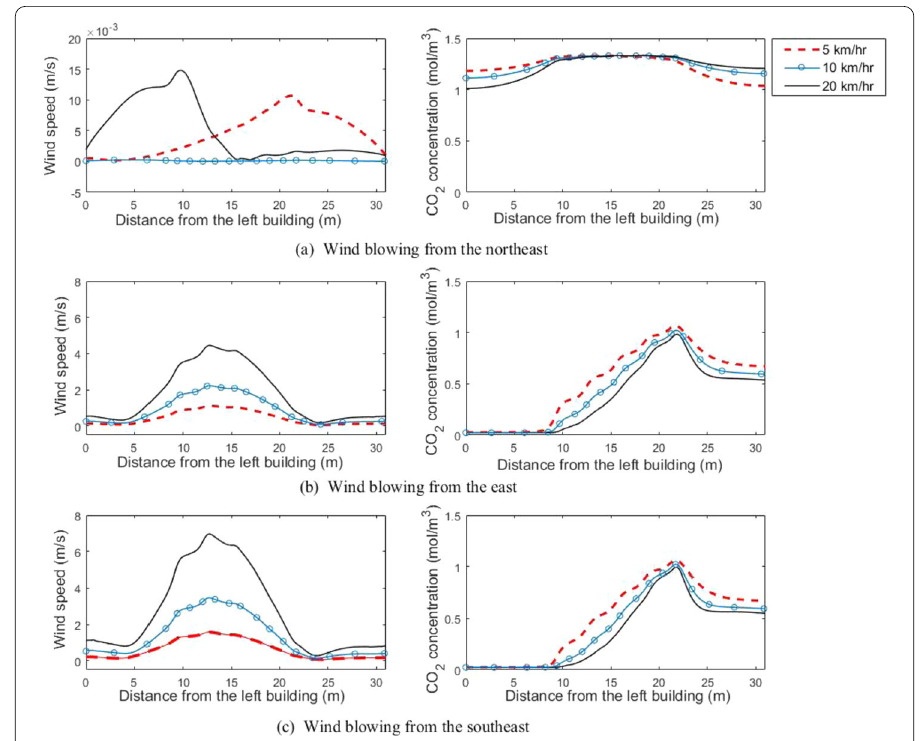
Figure 6 Comparison of wind-velocity profiles and CO 2 -concentration profiles at 1.5-meter height above the ground obtained from model with various conditions of the inlet wind speed and its blowing direction